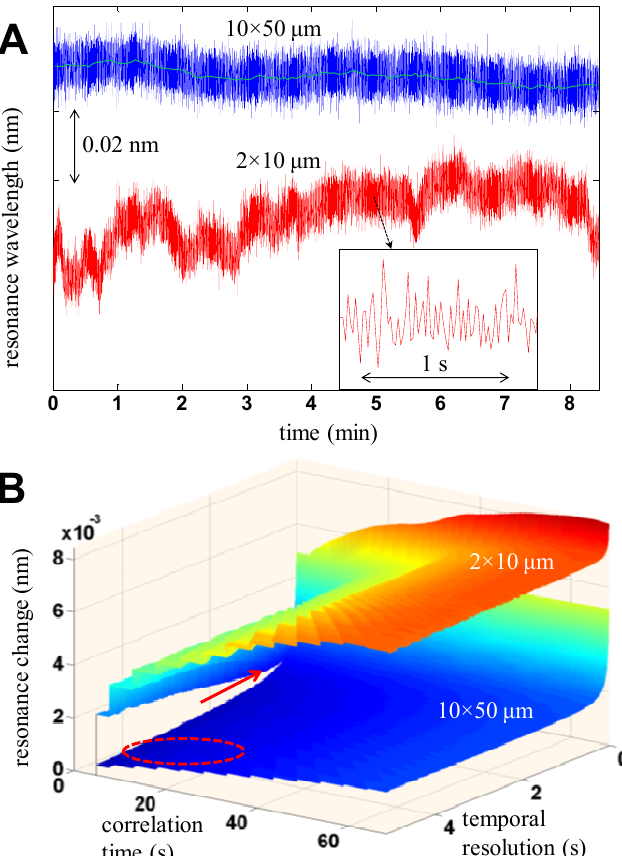
Figure 5. Example of stability differences when performing microspectroscopy on areas of different size (10 × 50 or 2 × 10 μ m). The sensor output parameter is the resonance wavelength of plasmonic gold nanodisks on the surface (in nm). The baseline of the idle system is monitored in ( A ) showing the same short-term noise for both A , but improved stability for the higher A . The change in sensor parameter between two acquisitions as a function of the temporal resolution and the elapsed time between the acquisitions is shown in ( B ). The arrow and circle indicate the lowest noise for the smaller and larger A respectively. Reproduced with permission from Reference [15] (Copyright 2009 American Chemical